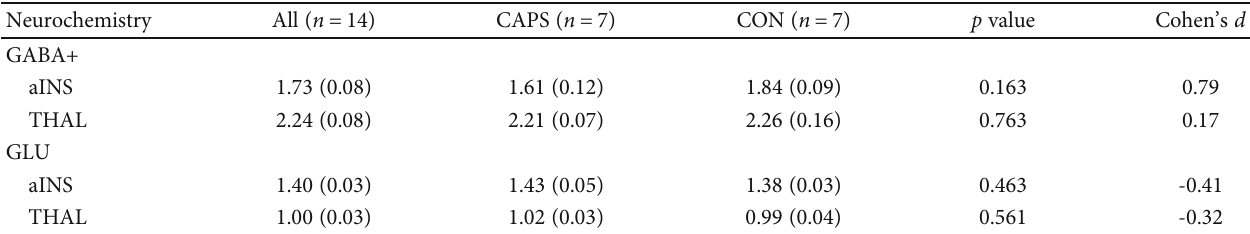
Table 2: Average GABA+ and GLU levels of the right thalamus and right insular cortex.